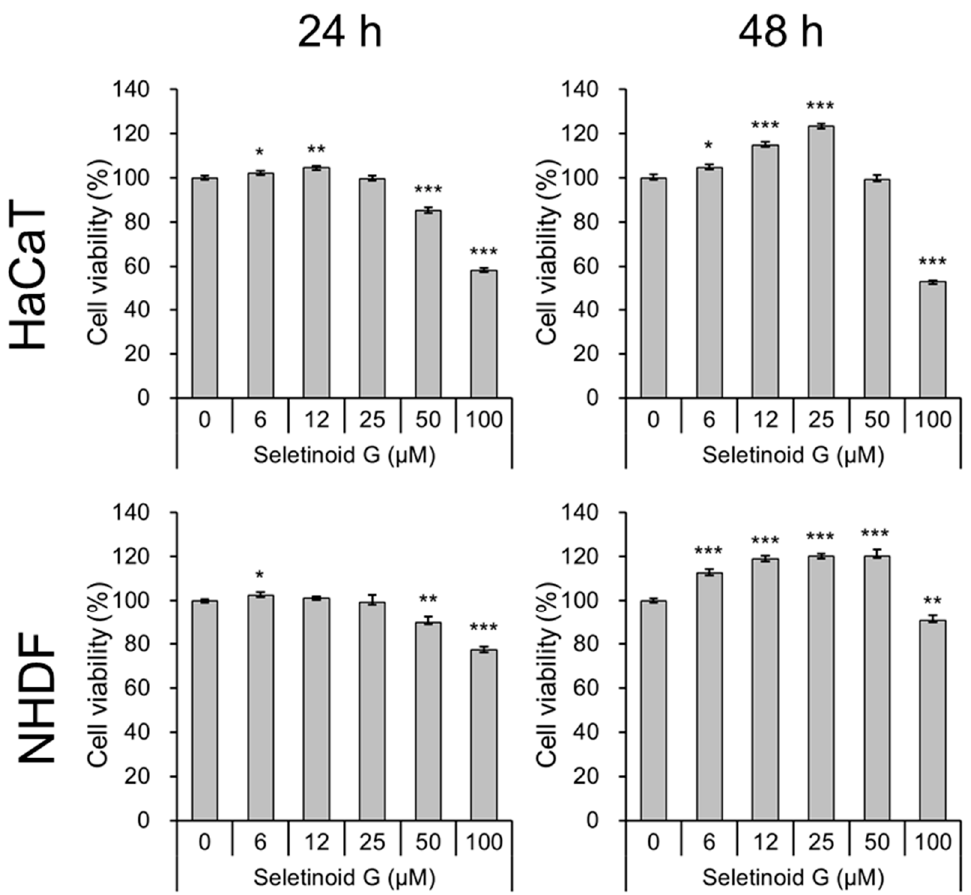
Figure 1. Cell viability test of seletinoid G on a human keratinocyte cell line (HaCaT) and normal human dermal fibroblasts (NHDF). The cell viability of HaCaT cells and NHDF treated with seletinoid G at different concentrations for 24 and 48 h was measured by CCK ‐ 8 assay. (* p < 0.05; ** p < 0.01; *** p < 0.001 vs. the untreated group).